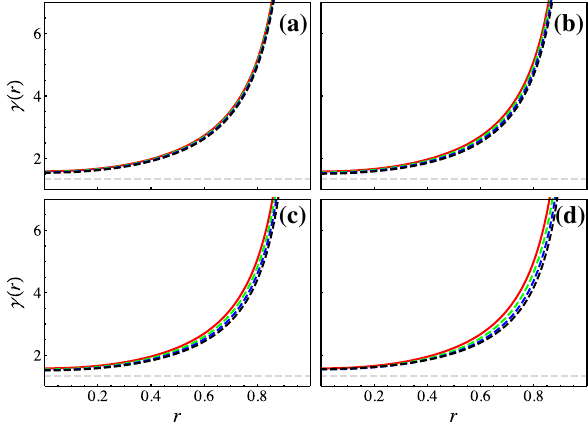
Fig. 7 Radial velocity v 2 r for M = 0 . 2, R = 1, c 1 = 0 . 5 and a C = − 0 . 1, b C = − 0 . 2, c C = − 0 . 3, d C = − 0 . 4. α = 0 . 1 (red line), α = 0 . 3, (green line), α = 0 . 5 (blue line), α = 0 . 7 (black line)